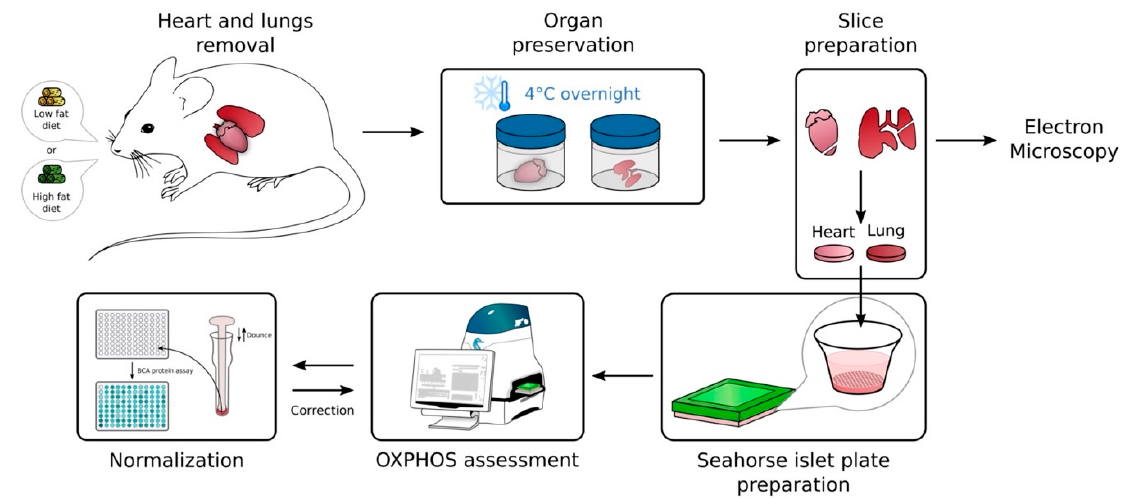
Figure 5. Schematic representation of the methodology used to measure oxygen consumption in 4 °C conserved tissues with XFe24 Seahorse. Heart and lung samples have been freshly removed from untreated/treated mice and quickly stored at 4 °C overnight. Next day, tissues have been dissected and cut in small pieces of tissue for electron microscopy and oxygen consumption (OXPHOS assess- ment) analysis. Following measurements, protein concentrations of tissues have been determined to normalize oxygen consumption